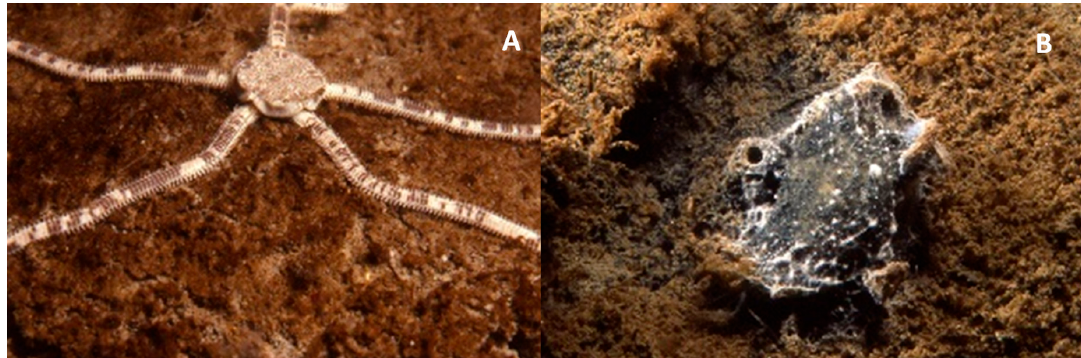
Figure 8. (A ) An ophiuroid, Hemipholis elongata, at the sediment surface where it is not usually found on a seabed of rich organic detritus; ( B ) A sulfidic environment with organic detritus, anoxic sediments, sulfur-oxidizing bacteria, and the burrow of a live Diopatra cuprea (polychaete). Both photos taken in summer 1990; both organisms collected for later taxonomic determination (Photos curtesy of Franklin Viola for use by N.N. Rabalais).